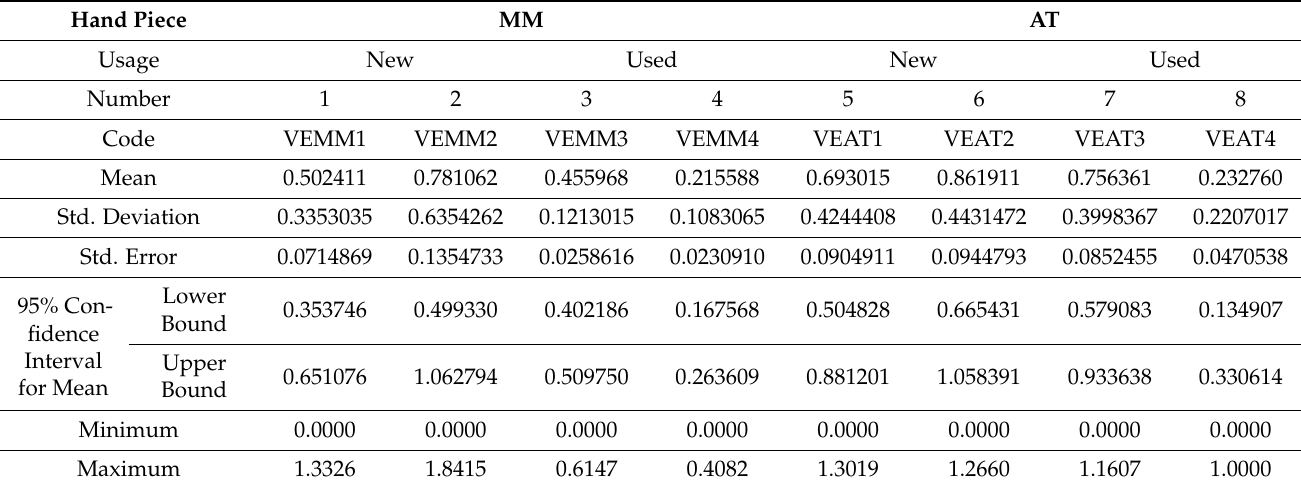
Table 10. Descriptive statistics of 1/3 octave band vibration transmissions of hand